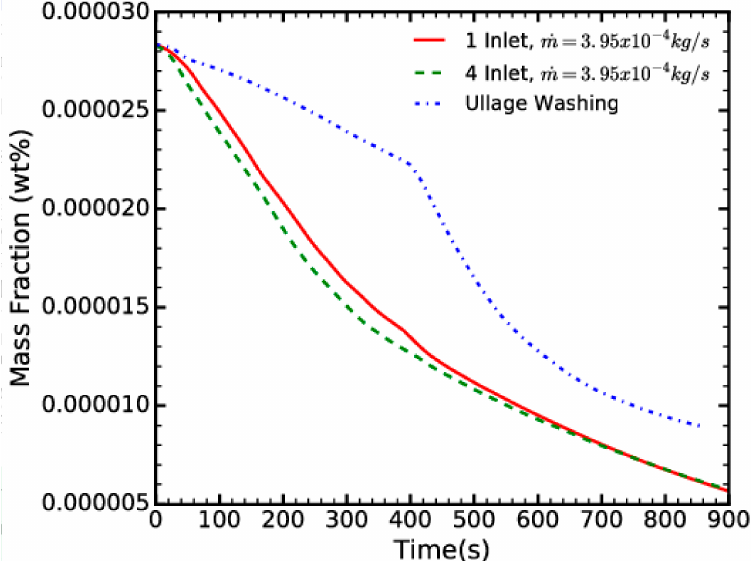
Figure 8. Time evolution of the mass fraction of water in the fuel for the single-inlet and four-inlet cases, as well as a case where NEA is pumped directly into the ullage (ullage washing). The inlet velocity of the three cases is adjusted accordingly so that the mass flow rate remains the